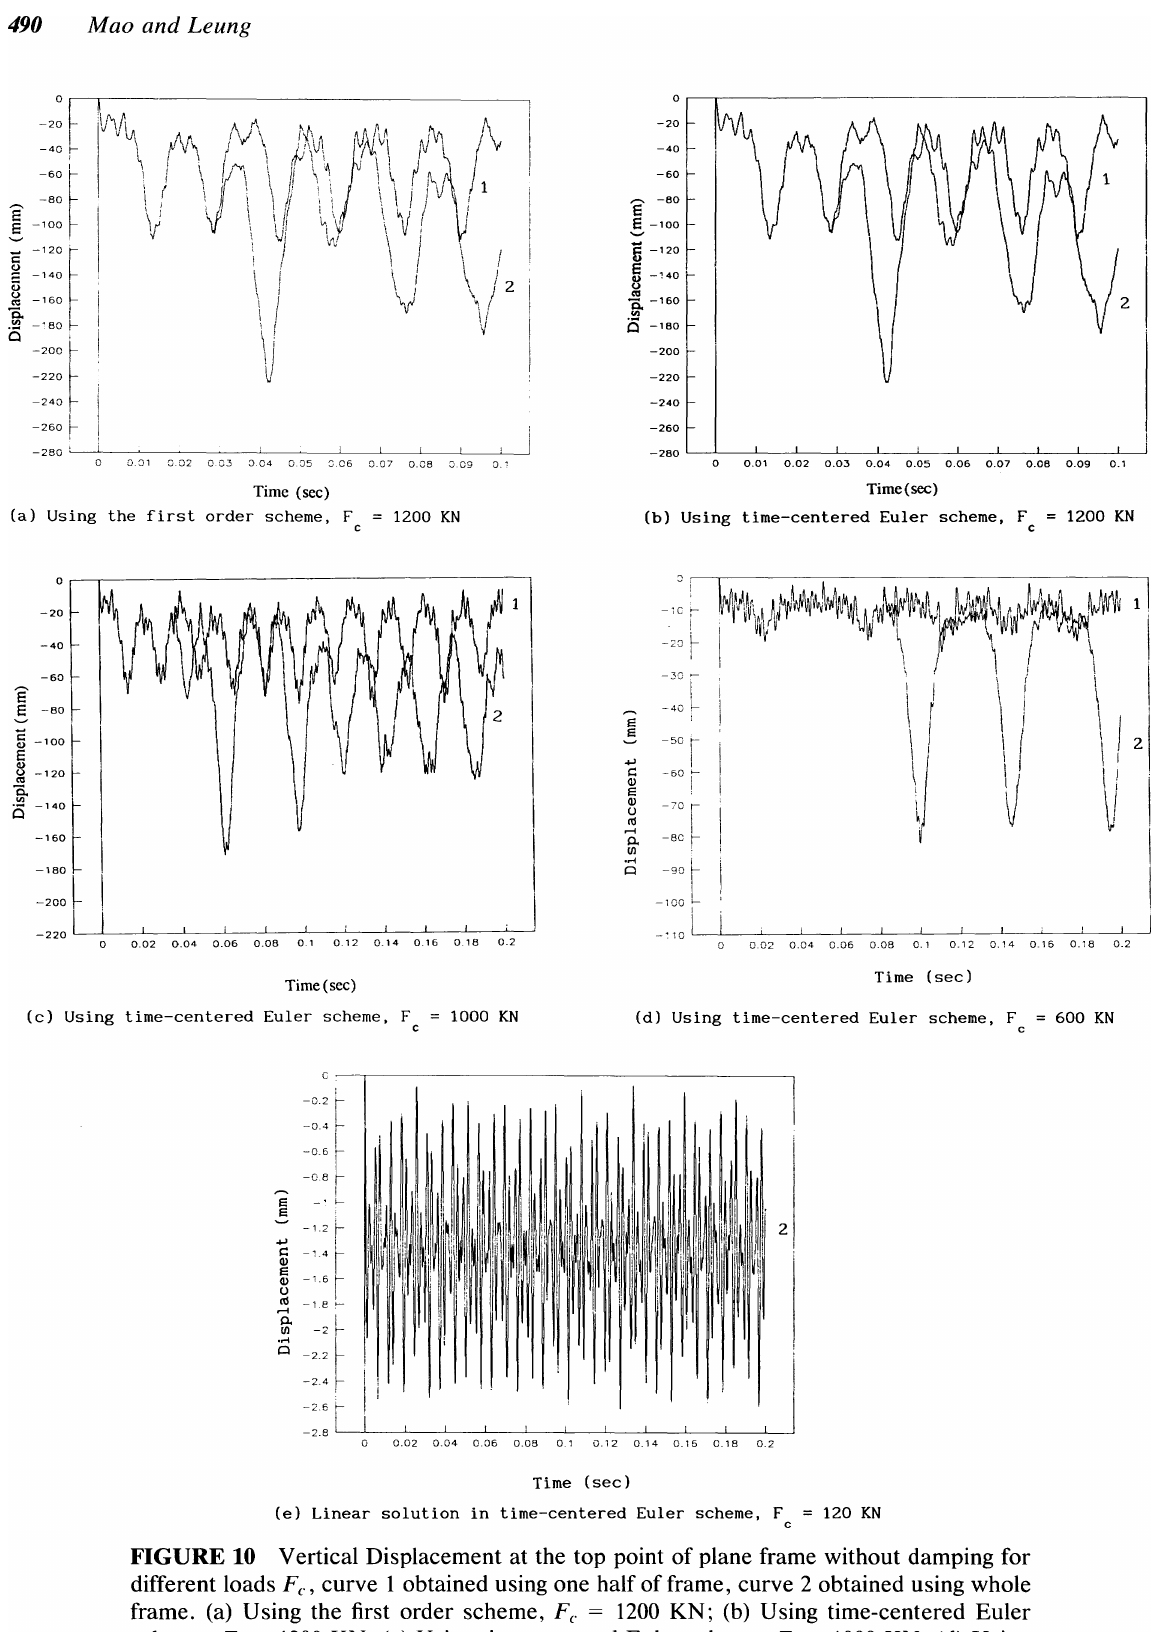
FIGURE 10 Vertical Displacement at the top point of plane frame without damping for different loads Fe, curve 1 obtained using one half of frame, curve 2 obtained using whole frame. (a) Using the first order scheme, Fe = 1200 KN; (b) Using time-centered Euler scheme, Fe = 1200 KN; (c) Using time-centered Euler scheme, Fe = 1000 KN; (d) Using time-centered Euler scheme, Fe = 600 KN; (e) Linear solution in time-centered Euler scheme, Fe = 120